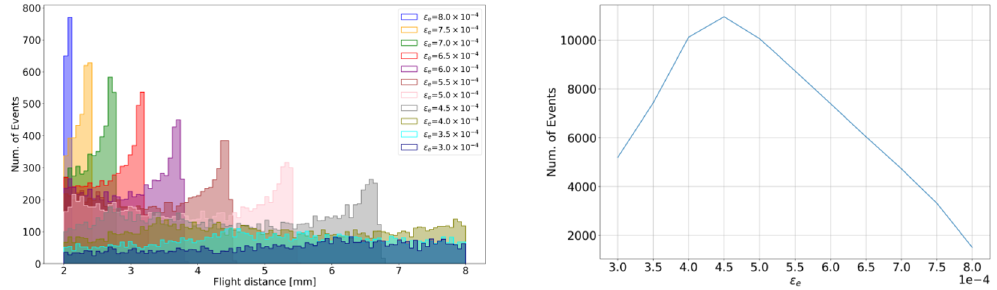
Figure 7 . (Left panel) The transverse flight distance d xy of 17 MeV X boson for ε e in 0.5 × 10 − 4 steps from 3 × 10 − 4 to 8 × 10 − 4 ; (Right panel) The number of events that pass the baseline cuts and satisfy 2 mm ≤ d 8 mm from the sample of 10 5 generated signal xy ≤